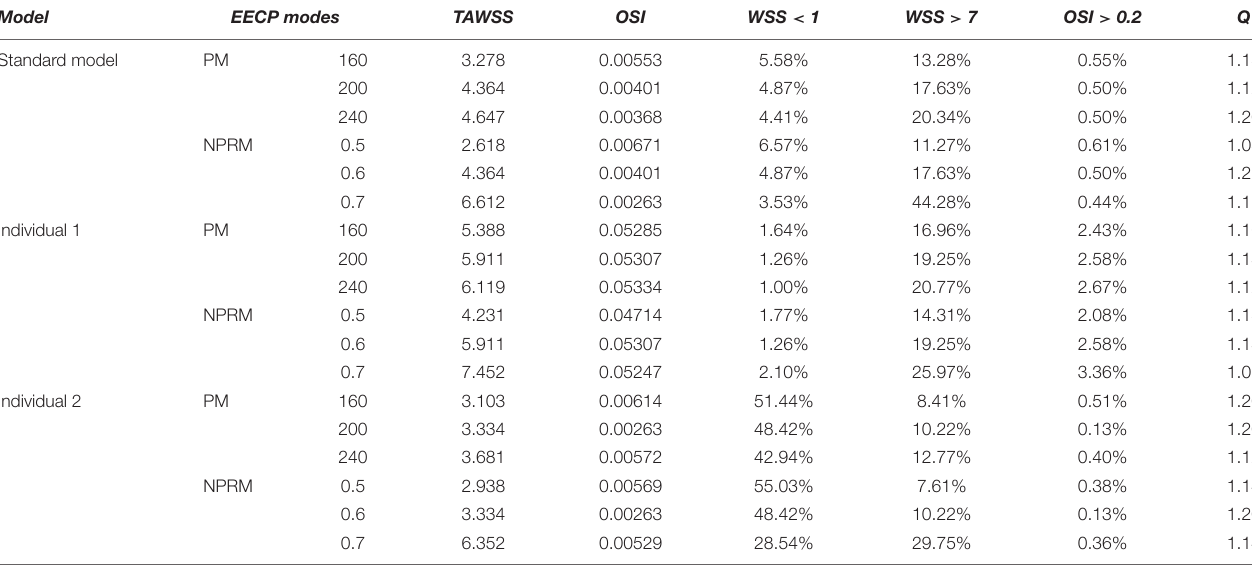
TABLE 3 | Variations of TAWSS, OSI, Q value, and the ratio of the hemodynamic risk area in the three models under different counterpulsation modes.